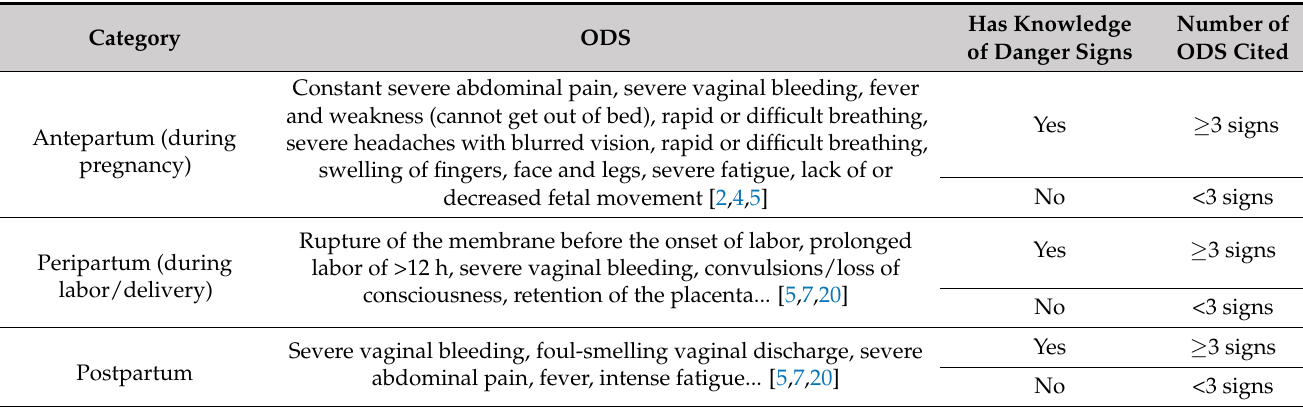
Table 2. Operational definitions of